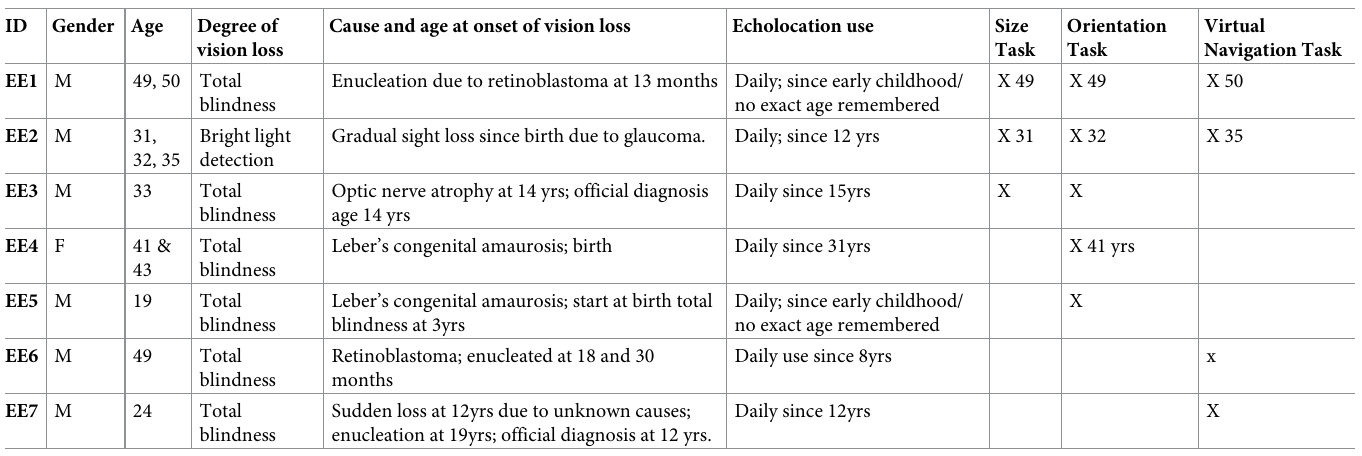
Table 2. Details of blind echolocation experts.